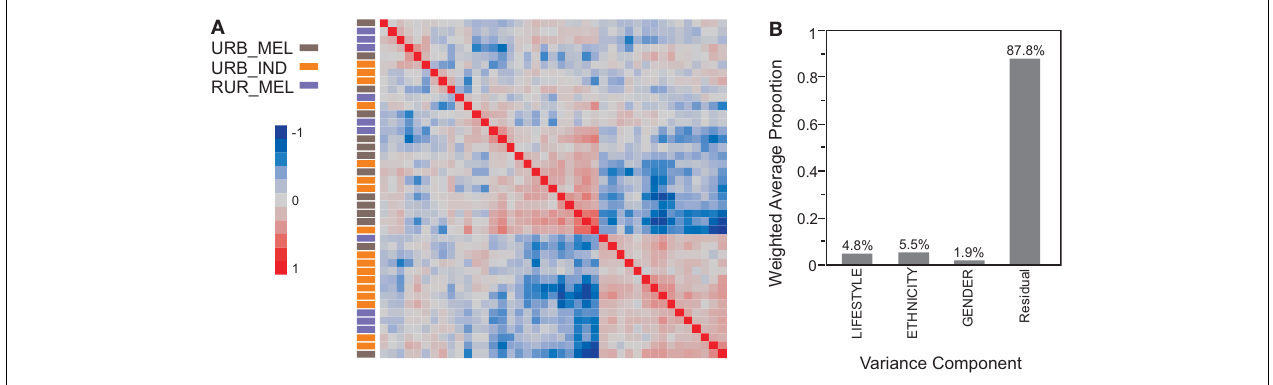
respectively. Red squares indicate strong positive correlation, blue squares indicate strong negative correlation, and lighter shades of red and blue indicates weak correlations. (B) Shows the weighted average of the variance captured by the first five principal components that is explained by Lifestyle, Ethnicity, and